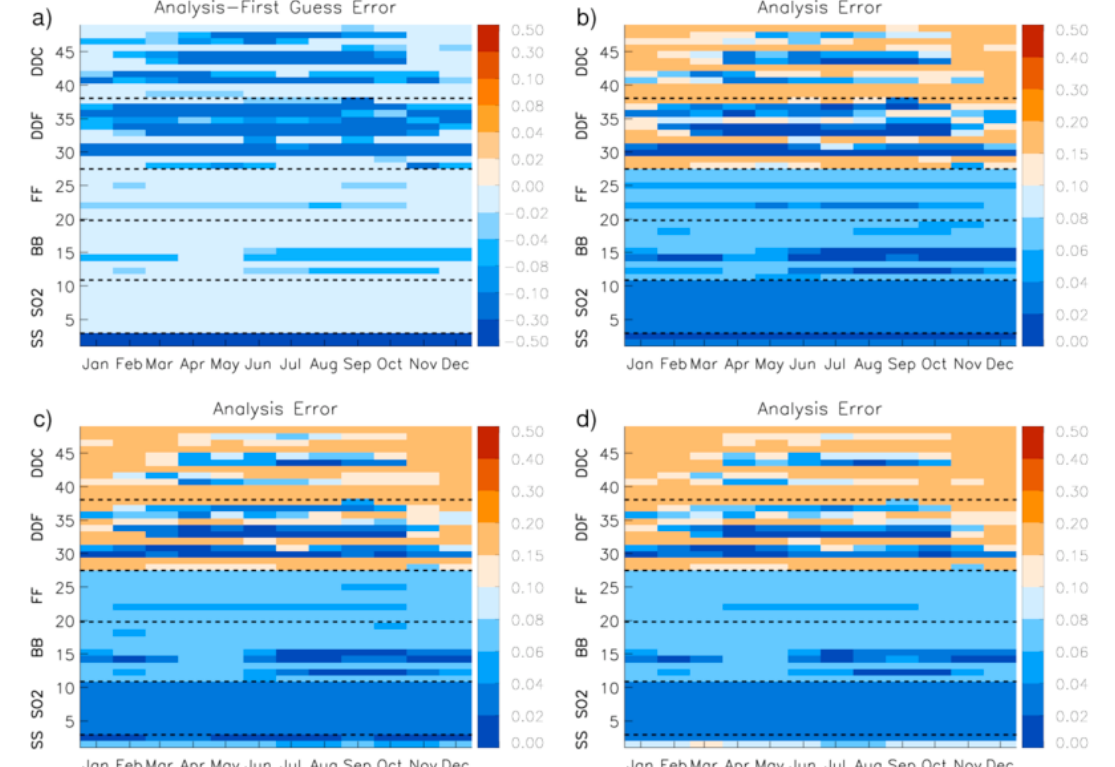
Figure 11. Fig. 11. (a) Difference in monthly mean errors (Analysis – First Guess) with the model error defined as 0.02. The monthly mean analysis error [%] for the estimated emission fluxes when the model error is defined as (b) 0.02, (c) 0.1 and (d) 0.15. The number of rows in the figure corresponds to the number of elements in the control vector. Each row corresponds to the seasonal cycle of analysis error of a given emission flux and region. The rows between different species are separated by black discontinuous lines. The red/blue colors in (a) indicate positive/negative differences whereas in (b) , (c) and (d) they indicate relatively high/low values. Table 6. Same as Table 2 but for assimilations with varying model error